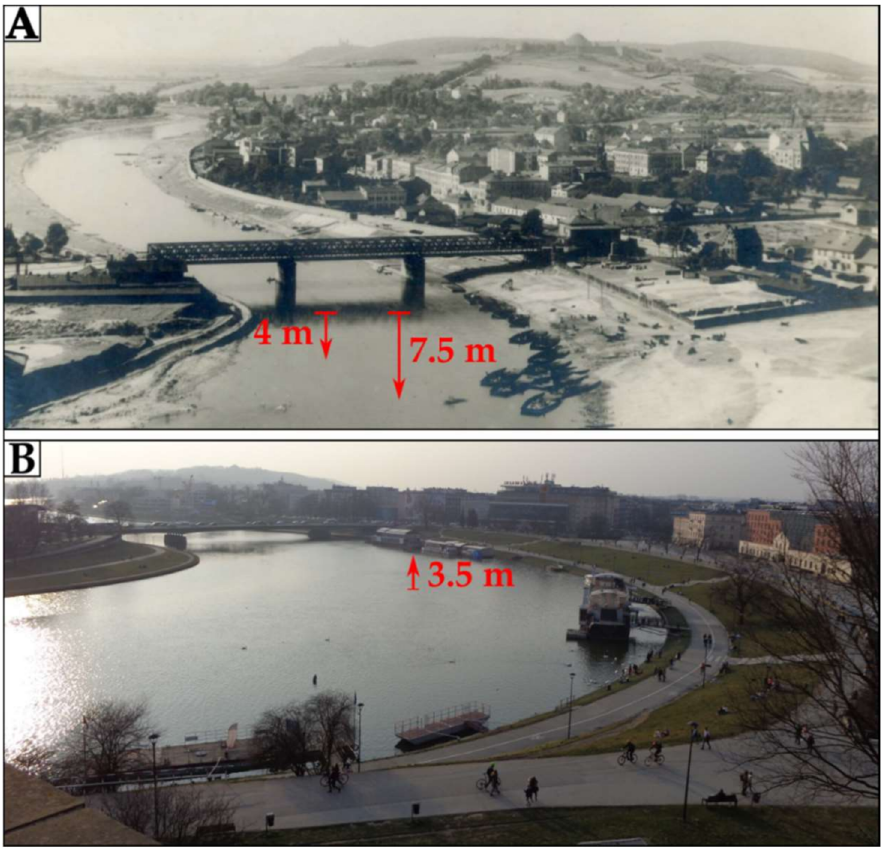
Figure 8. ( A )—the view of the Vistula upstream of the Wawel Hill, beginning of the 20th century. The narrowed and deepened river channel due to regulation works is well visible; the depth changed from 4.0 to 7.5 m. On the river banks there are low flood protecting levees [63]; ( B )—the same view in March 2021. Visible increase in the width of water table as a result of its raise by 3.5 m since the 1960s. On the river banks there are 3 to 4 m high flood protecting levees used as urban promenades. Photo by R.